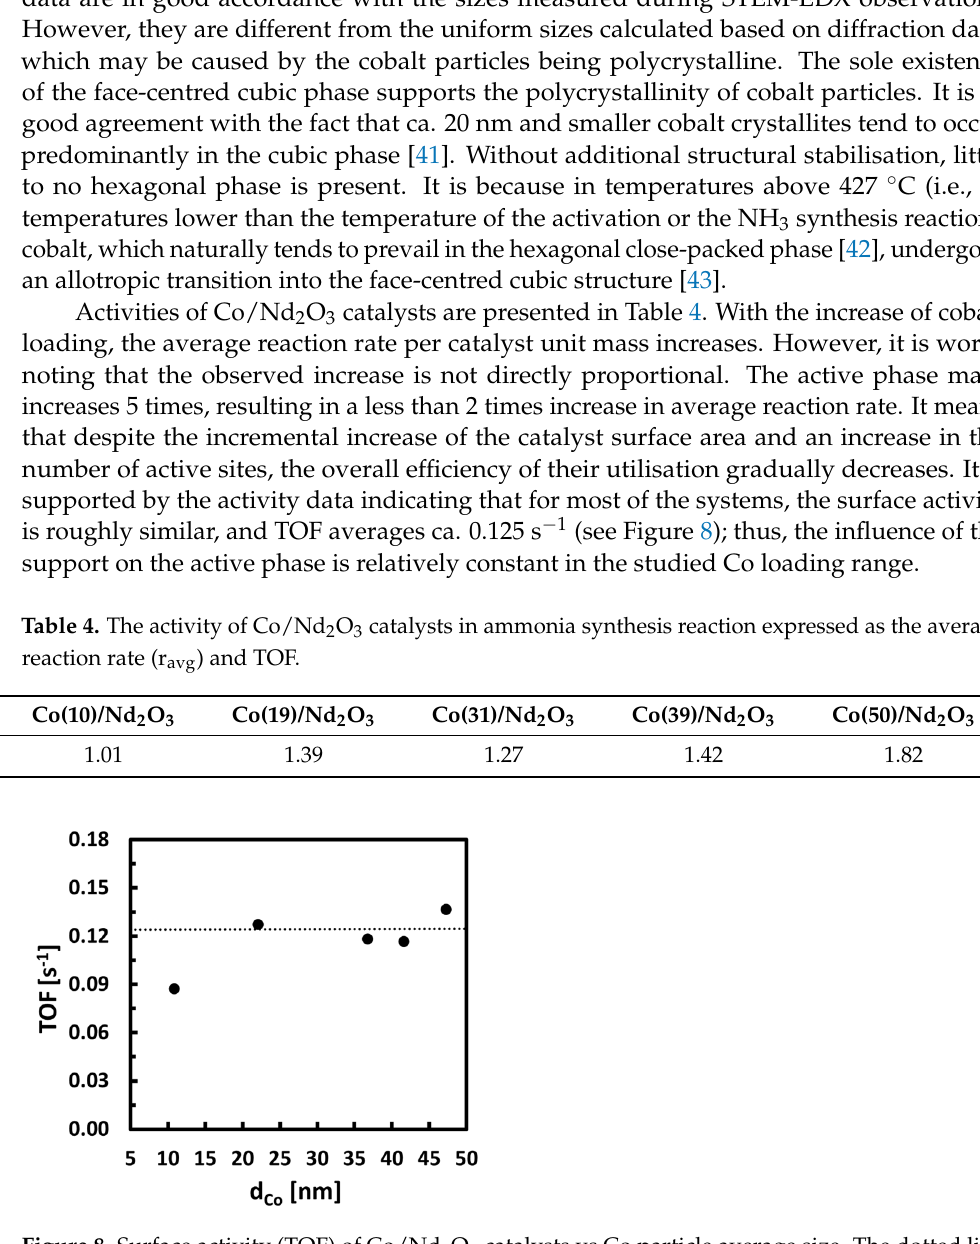
Figure 8. Surface activity (TOF) of Co/Nd 2 O 3 catalysts vs Co particle average size. The dotted line represents the average activity level of catalysts. Large dots represent particle sizes calculated on the basis of H 2 -TPD results (d H2-TPD, vide Table 3).